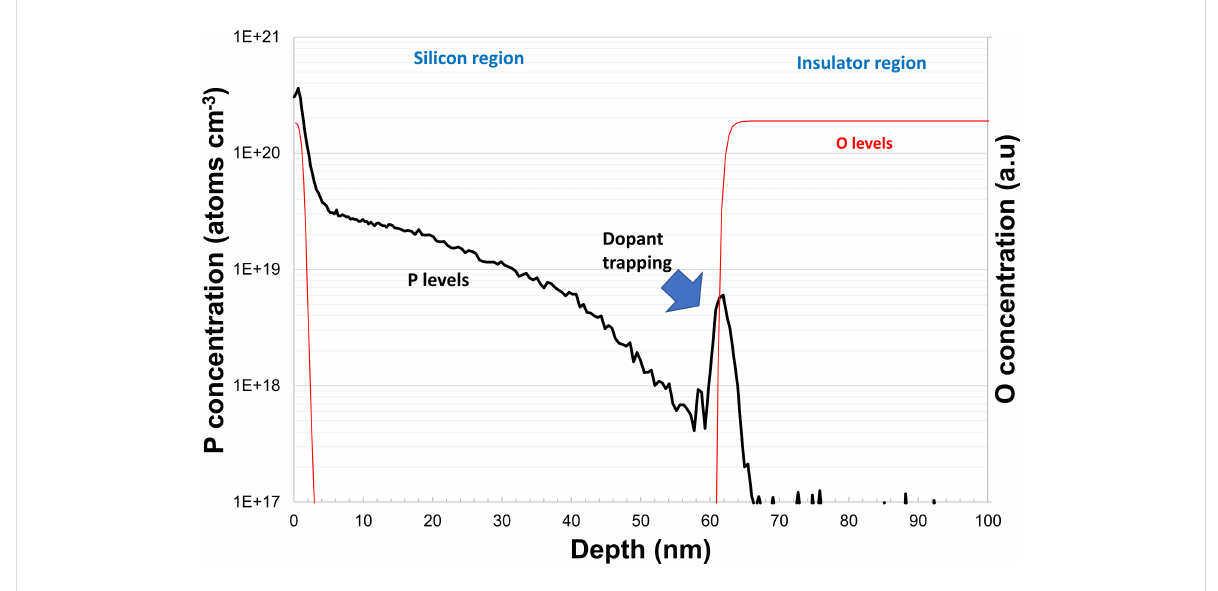
Figure 7: Secondary ion mass spectrometry analysis of a P-MLD-doped 66 nm silicon on insulator substrate. Blue line: P concentration, red line: O concentration.